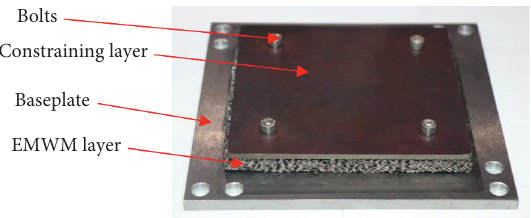
Figure 6: Image of the composite structure with EMWM